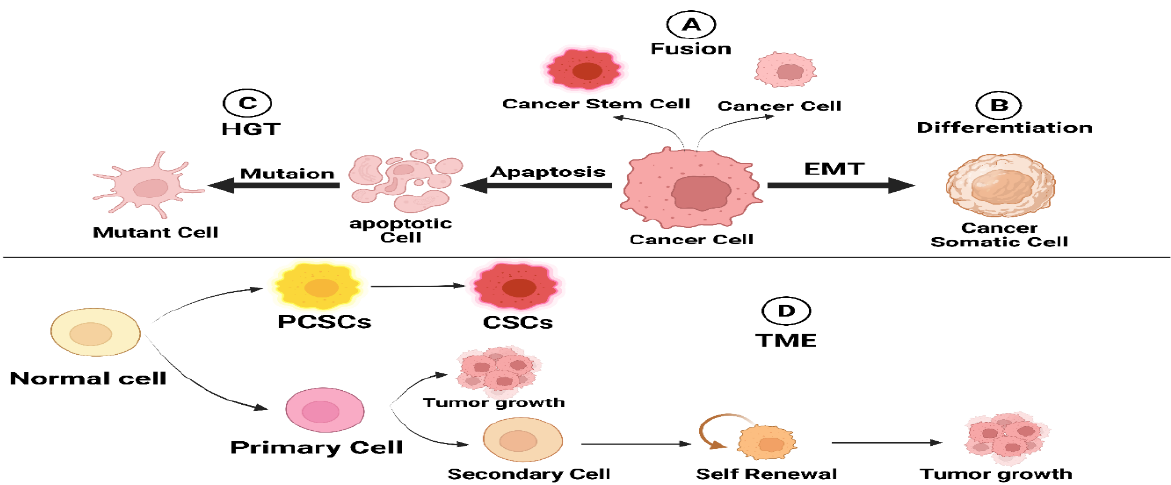
Figure 3. Schematic diagram summarizing the potential origins of CSCs.